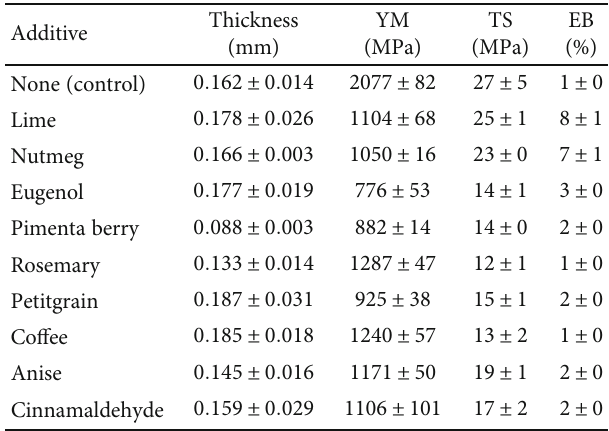
Table 4: Film thickness, Young ’ s modulus, tensile strength, and elongation at break of CAB fi lms incorporated with 20% essential